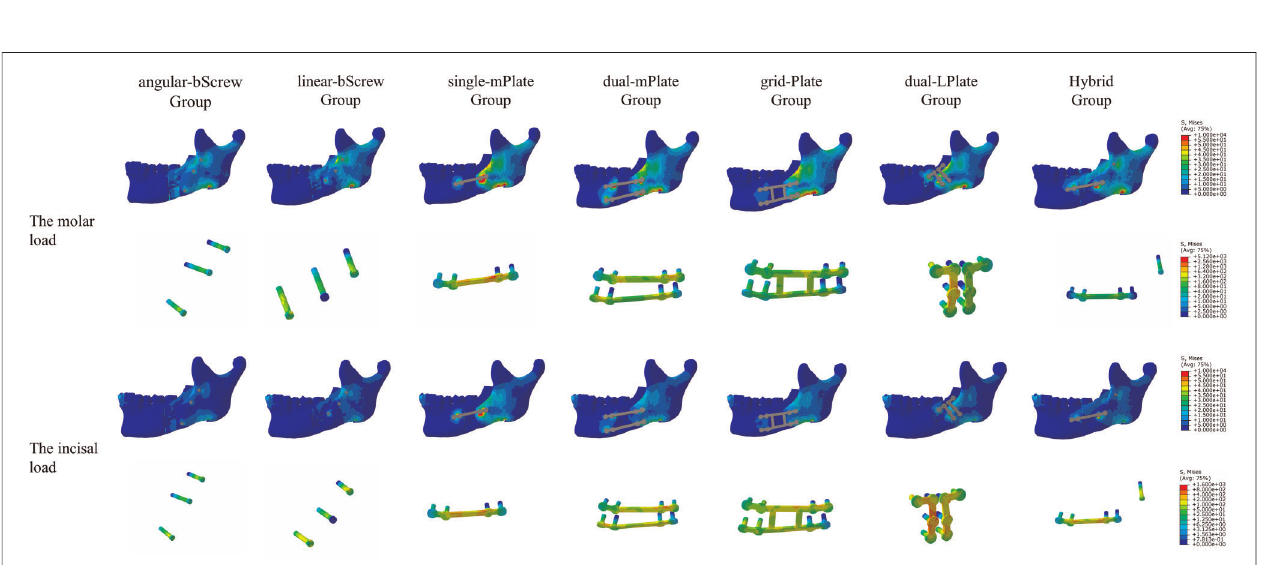
FIGURE 5 | Distribution of von Mises stress on mandibles and the von Mises stresses results for seven fi xation methods with a 10 mm